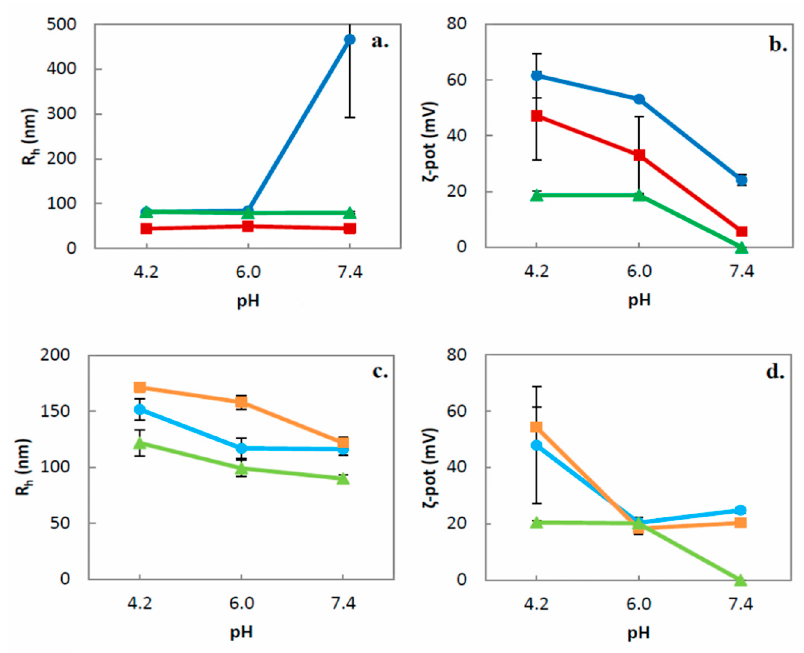
Figure 2. Hydrodynamic radius ( R h , nm) of a. GMO and c. PHYT nanosystems, as well as ζ -potential (mV) of b. GMO and d. PHYT nanosystems depending on the pH of the dilution medium ( ● : Lipid:PDMAEMA-b-PLMA 9:1, ■ : Lipid:PDMAEMA-b-PLMA 9:3, ▲ : Lipid:PDMAEMA-b-PLMA:P407 8:1:1).